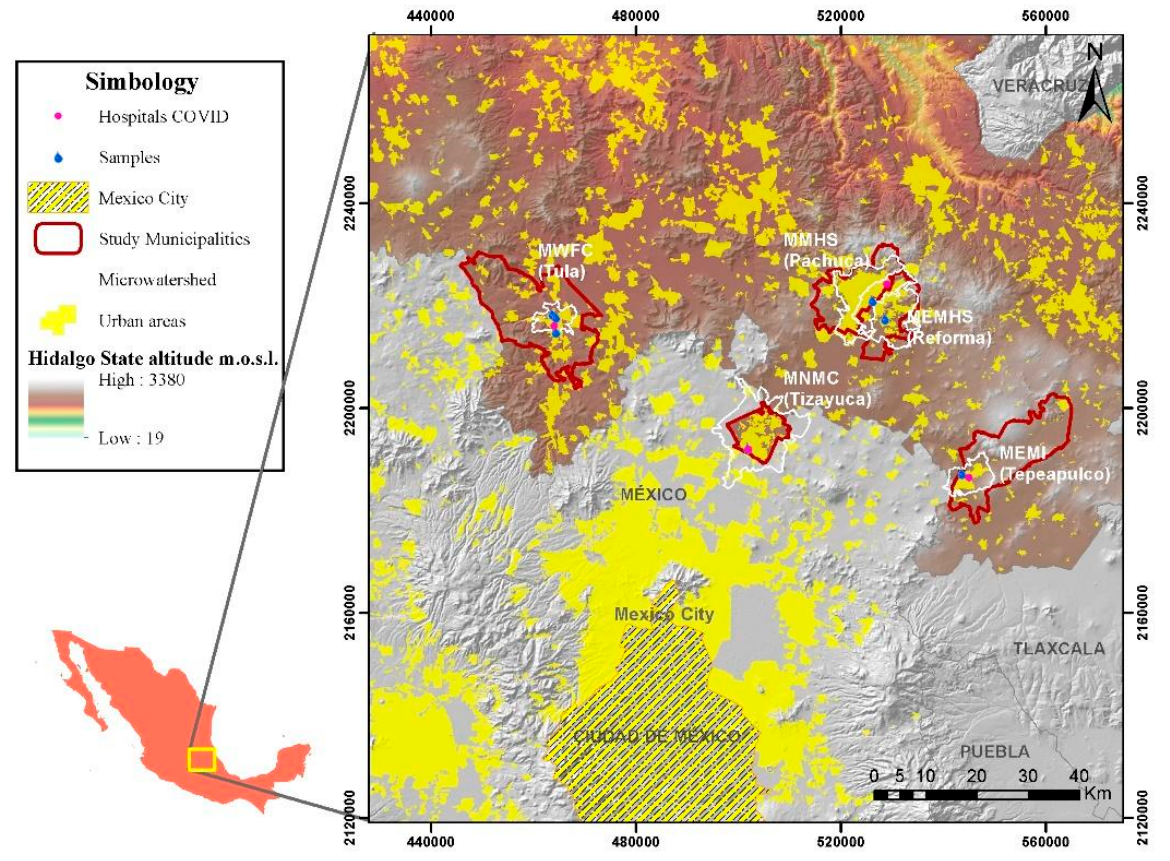
Figure 1. Study area and sampling site of five municipalities of the State of Hidalgo.